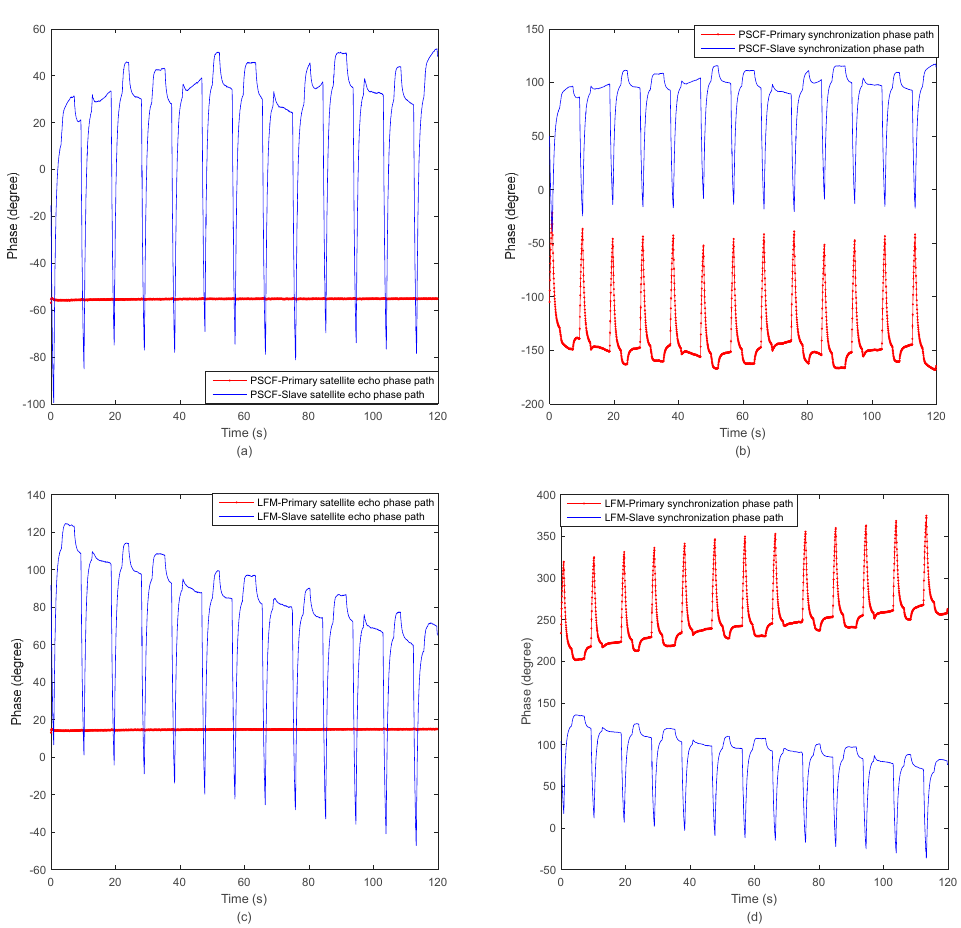
Figure 8. The echo phase and synchronization phase of the two satellites . ( a ) pulsed signal at carrier frequency (PSCF) ‐ the radar signal phases of the two satellites; ( b ) PSCF ‐ the synchronization phases of the two satellites; ( c ) linear frequency modulation (LFM) ‐ the radar signal phases of the two satellites; ( d ) LFM ‐ the synchronization phases of the two satellites.